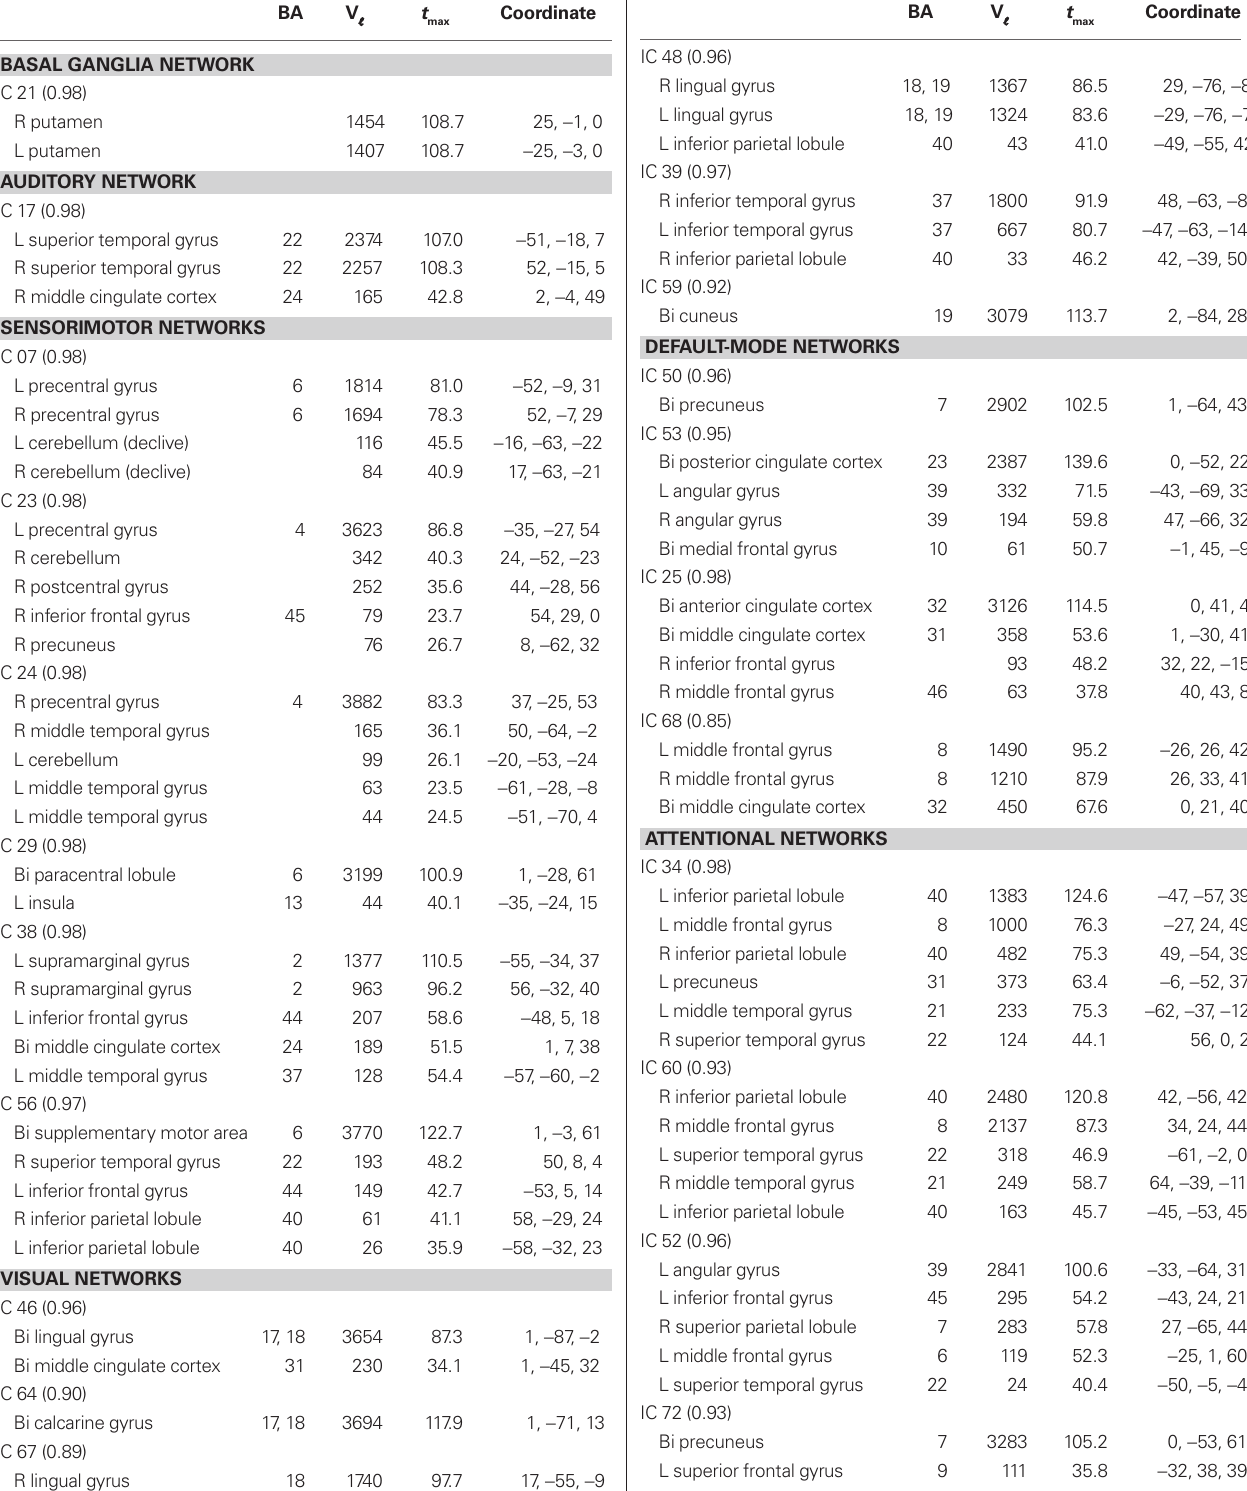
Table 2 | Peak activations of RSN SMs. The quality index ( I Brodmann area; V , number of voxels in each cluster; t  LPI